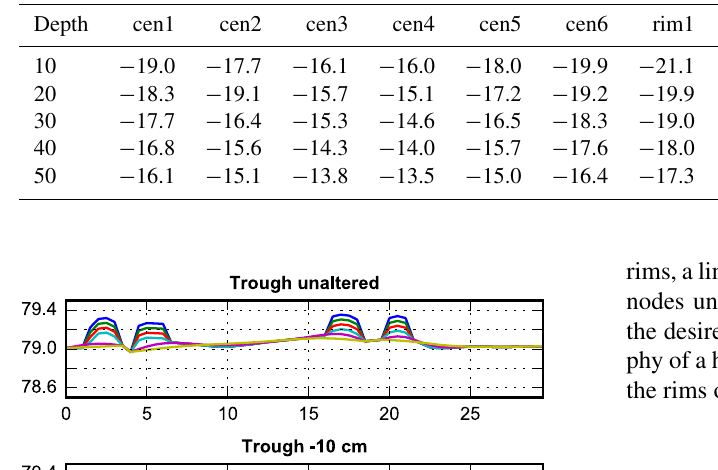
Table 2. Minimum observed temperature ( ◦ C) at each sensor rod and depth (cm).